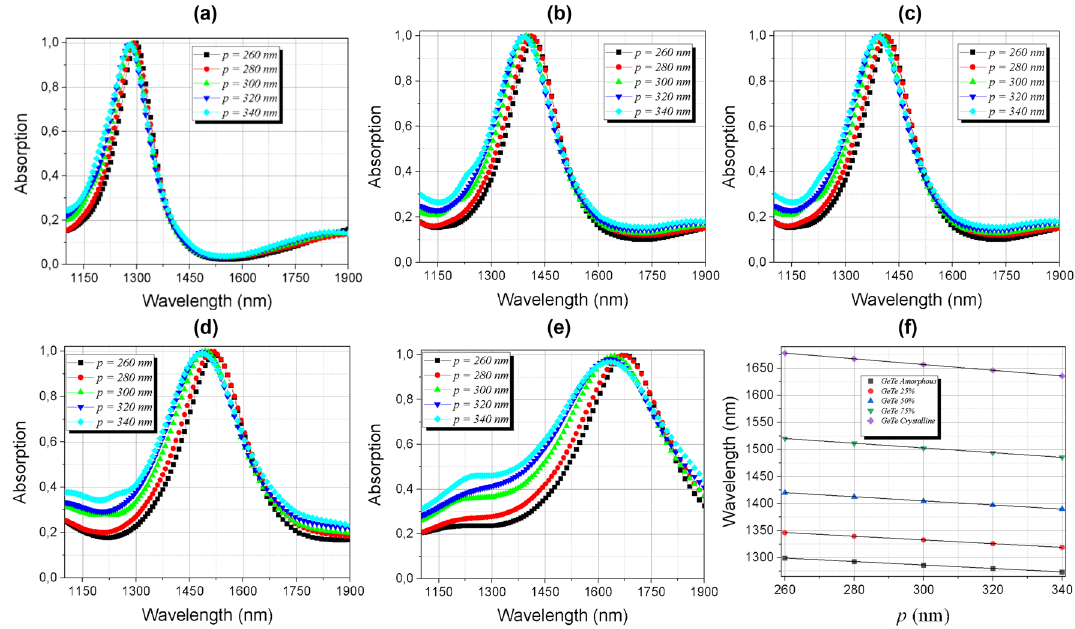
Figure 14. Absorption dependence of the periodicity p in the range of 1100 to 1900 nm ( a ) amorphous; ( b ) semi-crystalline (m = 25%); ( c ) semi-crystalline (m = 50%); ( d ) semi-crystalline (m = 75%); ( e ) crystalline phases and ( f ) linear dependence of the peaks of ( a – e ) with the thickness of the periodicity.